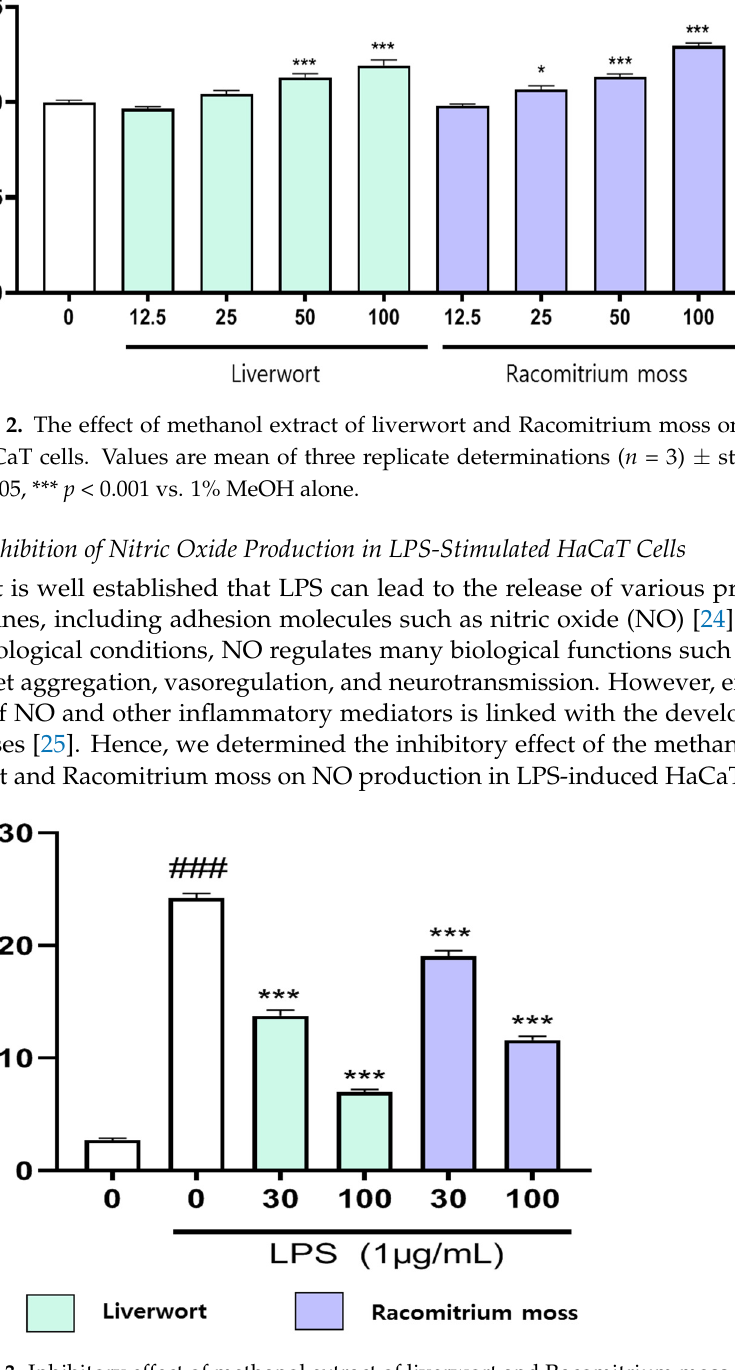
Figure 3. Inhibitory effect of methanol extract of liverwort and Racomitrium moss on NO production by LPS-stimulated HaCaT cells. Values are mean of three replicate determinations ( n = 3) ± standard deviation. ### p < 0.001 vs. 1% MeOH alone, *** p < 0.001 vs. LPS alone.